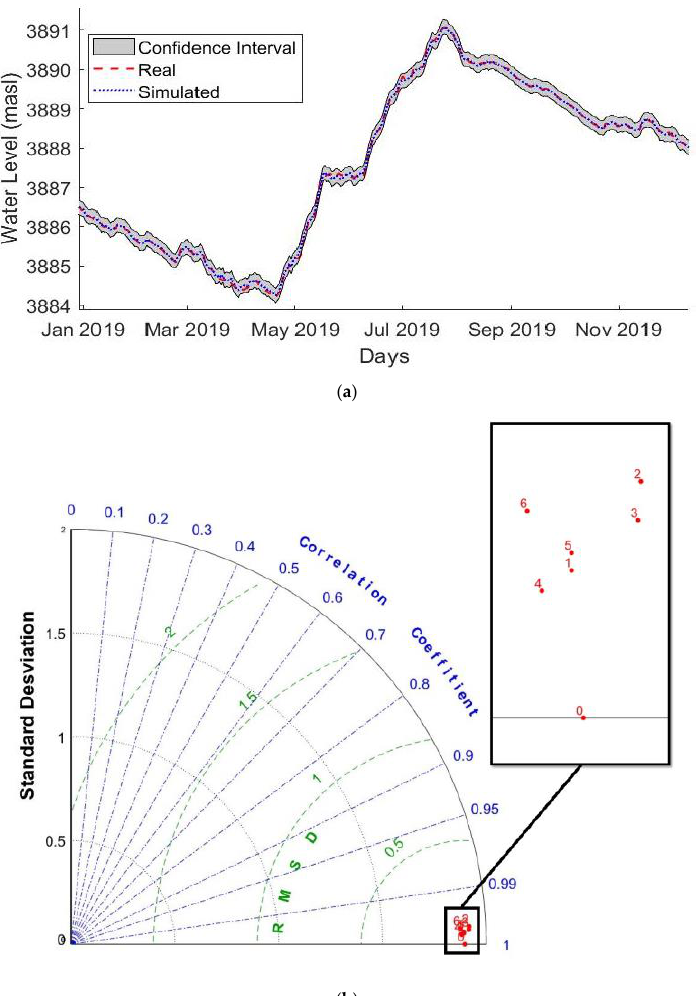
Figure 7. Graphic results of the best prediction results for NN. ( a ) Comparison of the best model (t + 4) with its confidence interval. ( b ) Taylor diagram. In this diagram, point 0 is real observation data, and 1 to 6 are the models from t + 1 to t + 6 respectively, as shown in Table 1.